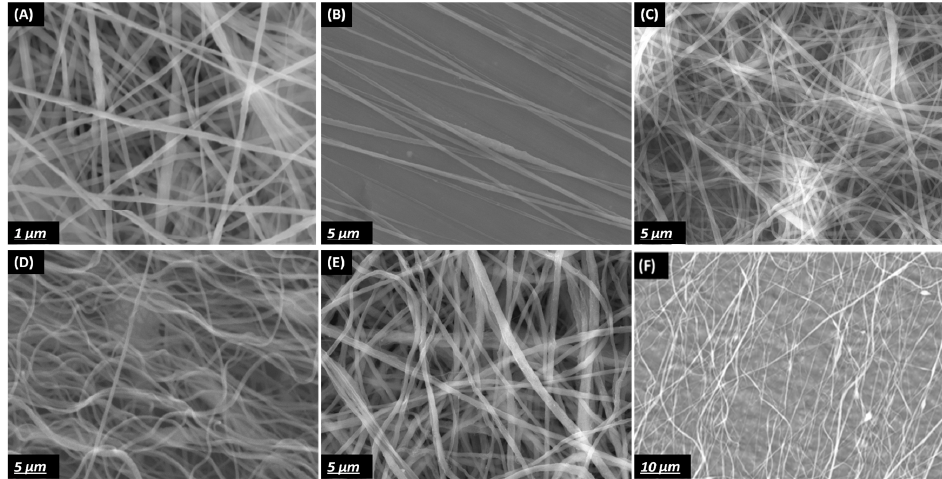
Figure 3. ( A ) SEM images of non-aligned PVDF 0 wt %, ( B ) CNT two-bar aligned PVDF 0 wt % CNT, ( C ) non-aligned PVDF 0.1 wt %, ( D ) CNT two-bar aligned PVDF 0.1 wt %, ( E ) CNT non-aligned PVDF 0.3 wt %CNT and ( F ) two-bar aligned PVDF 0.3 wt % CNT.